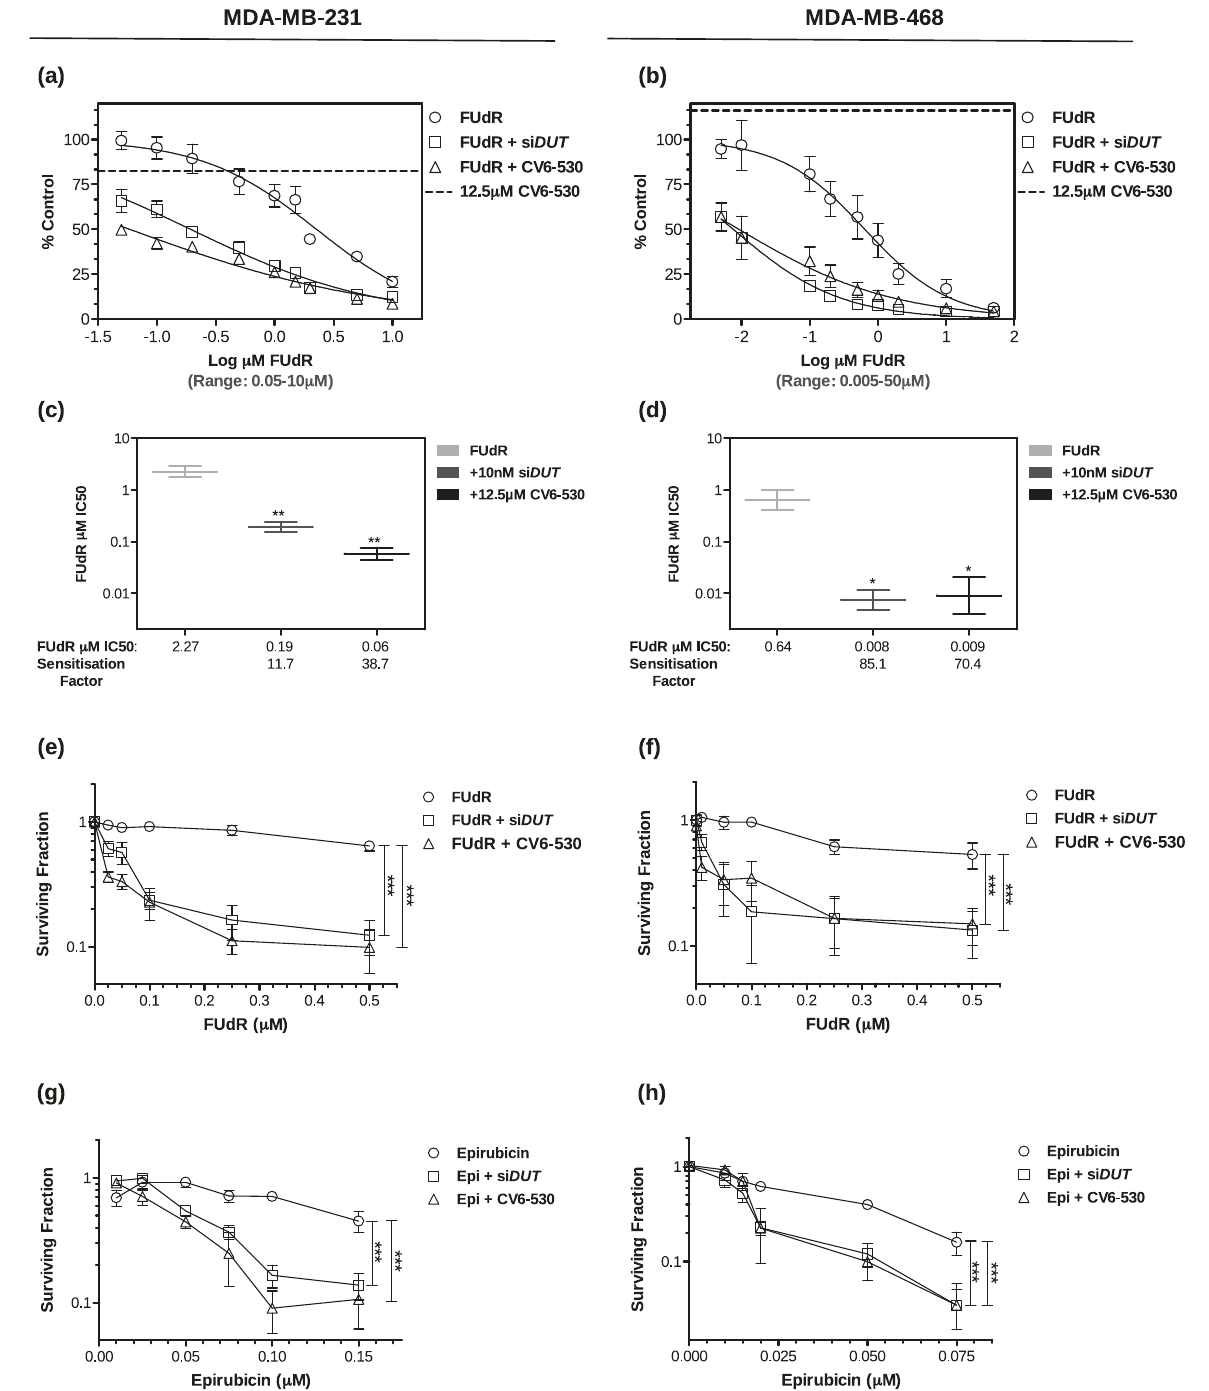
Fig. 1 Inhibition of dUTPase sensitises TNBC cells to fl uoropyrimidine and anthracycline chemotherapies. MDA-MB-231 and MDA-MB-468 cells were analysed for ( a , b ) cell viability following dUTPase inhibition (10 nM si DUT or 12.5 µM CV6-530) in combination with 0.05 – 10 µM or 0.005-50 µM FUdR for 96 h and quanti fi ed with CellTiter-Glo assay (Promega). The single-agent growth inhibitory effect of 12.5 µM CV6-530 is represented by a horizontal dotted line on both graphs to allow comparisons for each combination. Data points represent mean ± SEM percent growth inhibition ( N = 3) compared with vehicle-treated controls at 100%. c , d IC 50 values were calculated using Graphpad (Prism) and sensitisation factors were calculated by dividing the single-agent FUdR IC 50 by the IC 50 of the combination of FUdR and 12.5 µM